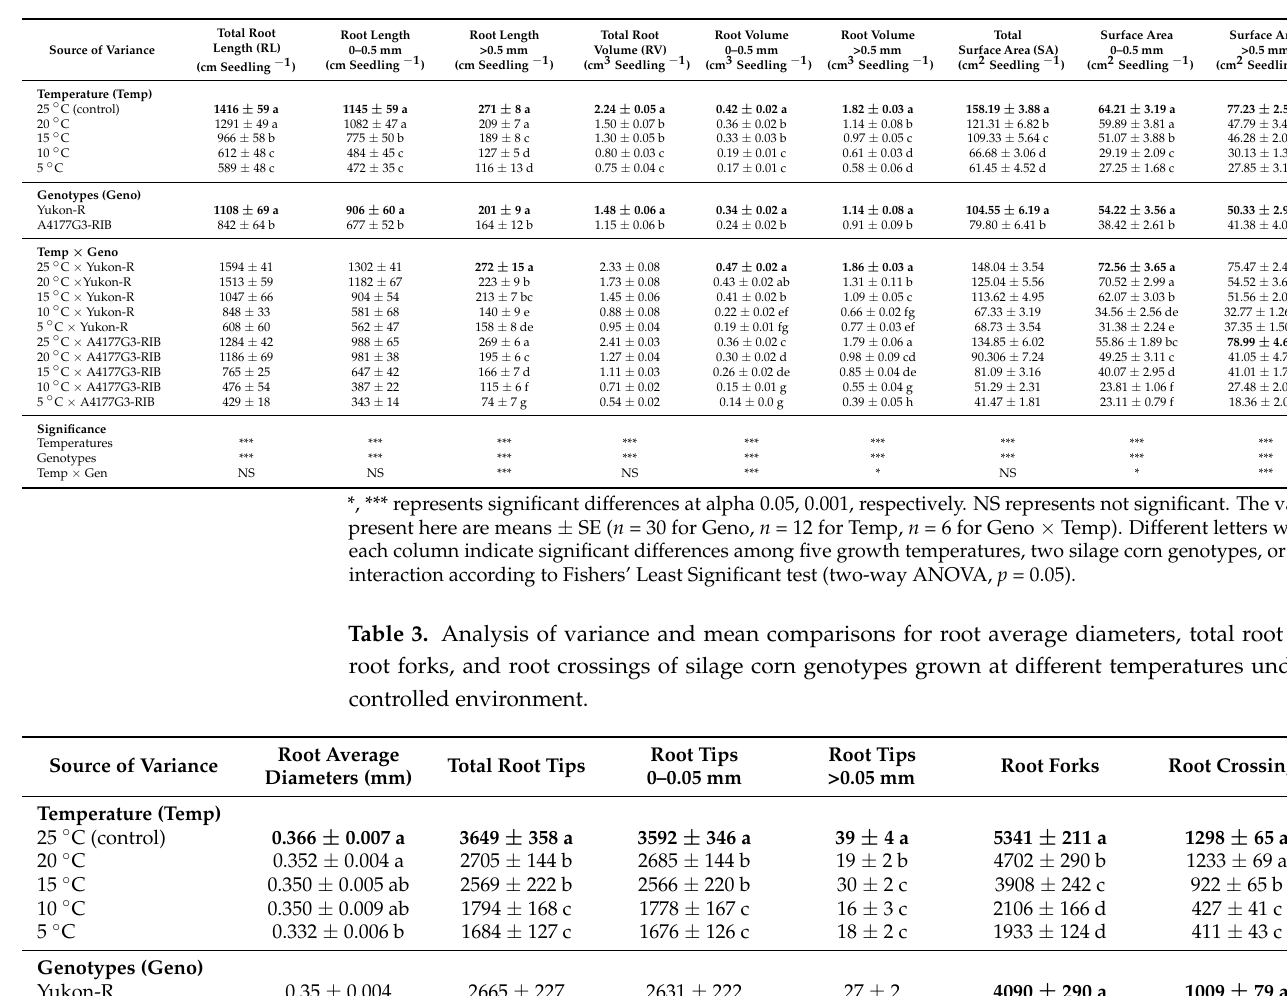
Table 2. Analysis of variance and mean comparisons for total root length, total root volume, and total surface area of silage corn genotypes, grown in different temperatures and with their interaction under controlled environmental conditions.